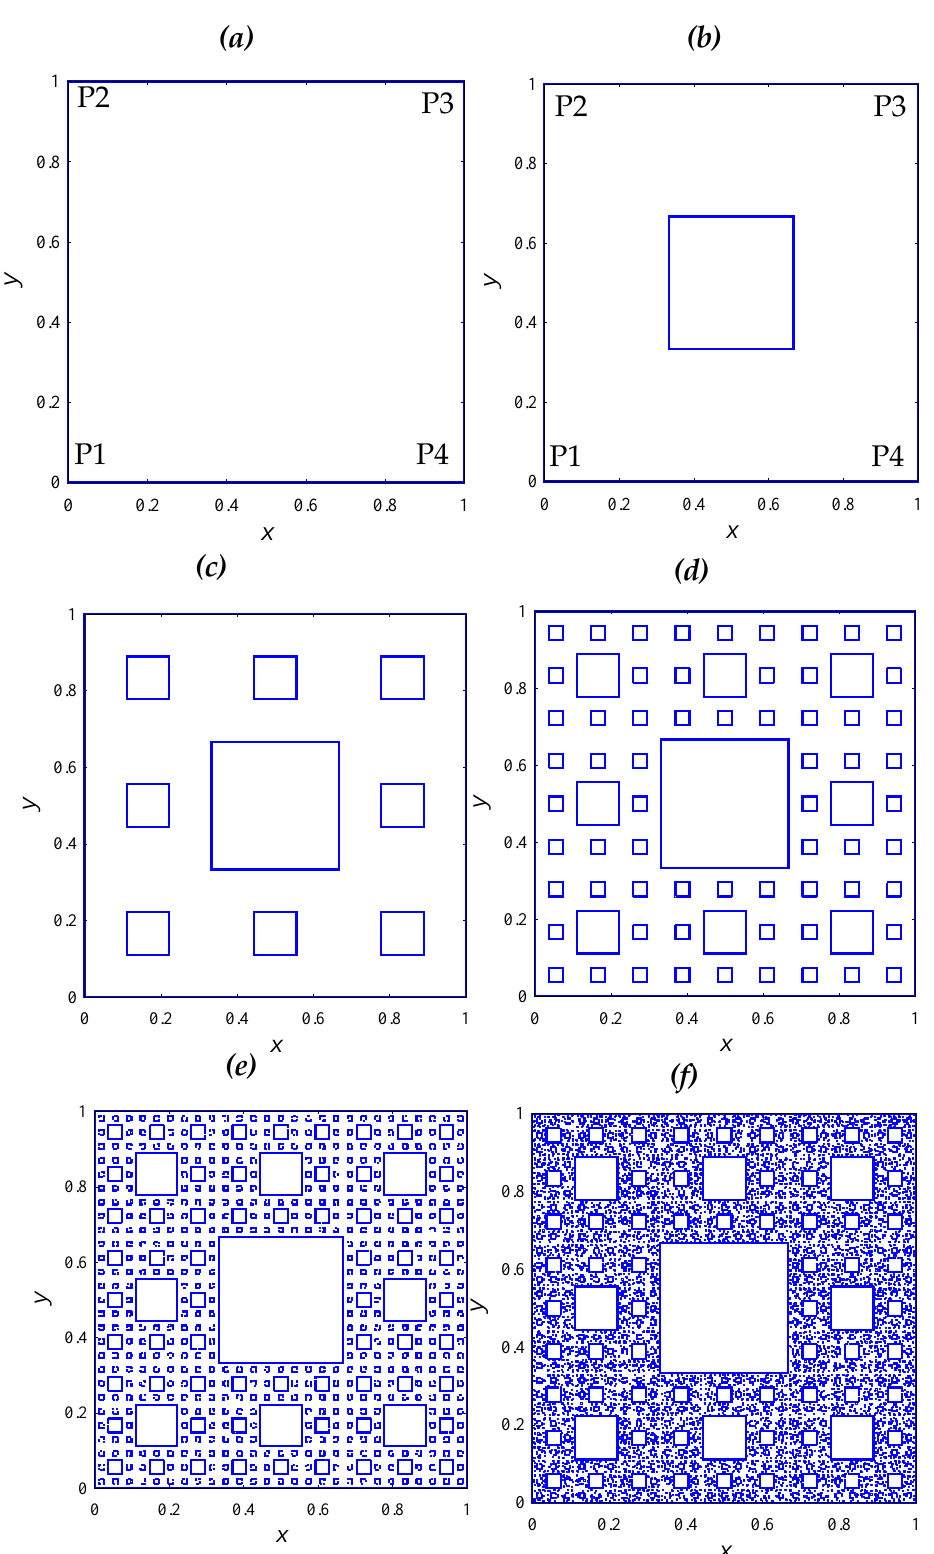
Figure 7. Level-controlled point clouds of the Sierpinski Carpet: ( a ) seed point cloud; ( b ) point cloud of ( a ) and the first level point cloud; ( c ) point clouds of ( b ) and the second level point cloud; ( d ) point clouds of ( c ) and the third level point cloud; ( e ) point clouds of ( d ) and the fourth level point cloud; and ( f ) point clouds of ( e ) and the fifth level point cloud.